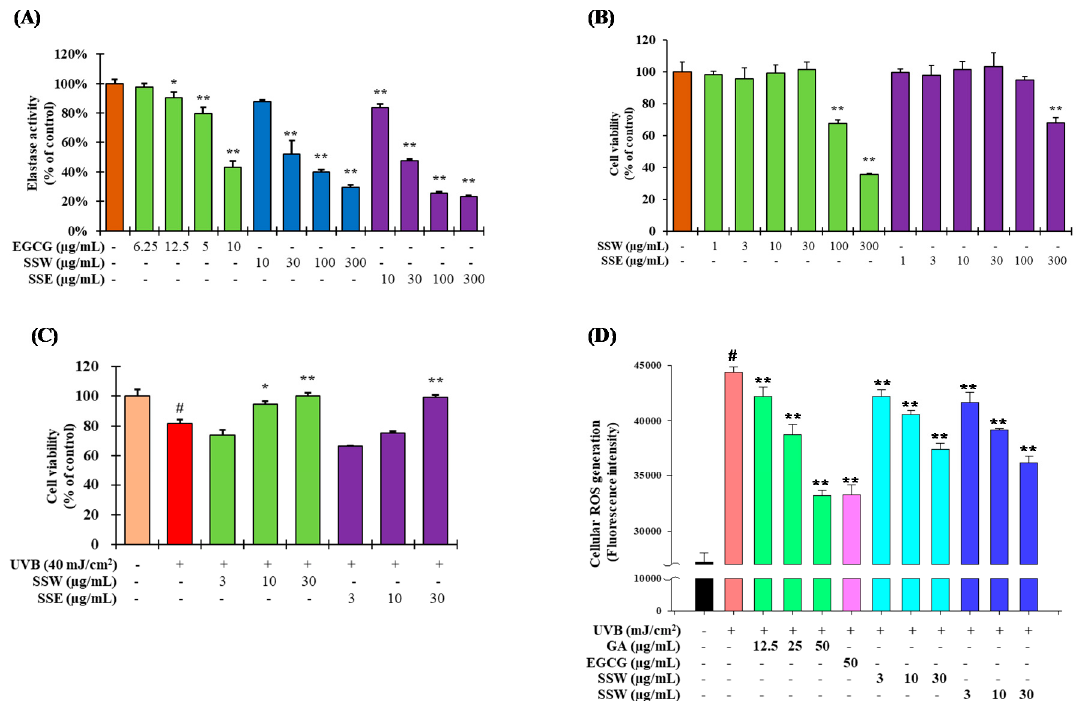
Figure 2. Comparison of anti-aging potential by SS. ( A ) Inhibitory e ff ects of SS stem extracts on elastase activity. The results are denoted as the mean ± standard deviation (SD) from triplicate experiments (** p ≤ 0.01, * p ≤ 0.05 compared with the control group). ( B ) Cytotoxicity of SS stem extracts in HaCaT cells. Cells (1 × 10 5 cells / mL) were seeded in a 96-well plate and treated with aqueous and ethanolic extracts of SS stem (SSW and SSE) at 1, 3, 10, 30, 100, and 300 µ g / mL. The cell viability was determined using 3- (4,5-dimethylthiazol-2-yl) -2,5-diphenyltetrazolium bromide (MTT) assay. ( C ) Phototoxicity of SS stem extracts in HaCaT cells. Cells (1 × 10 5 cells / mL) were treated with SSW and SSE at 3, 10, or 30 µ g / mL. After 24 h, UVB (40 mJ / cm 2 ) was irradiated and the cells were cultured in serum-free medium for 24 h. The cell viability was measured using the MTT assay. The data are denoted as the mean ± SD from triplicate results. (# p ≤ 0.01, compared with the non treated control (NT); ** p ≤ 0.01, * p ≤ 0.05 compared with the UV control group). ( D ) Reactive oxygen species (ROS) generation activity was measured using HaCaT cells according to the method described in materials and methods. EGCG: ( − )-epigallocatechin gallate; GA: gallic